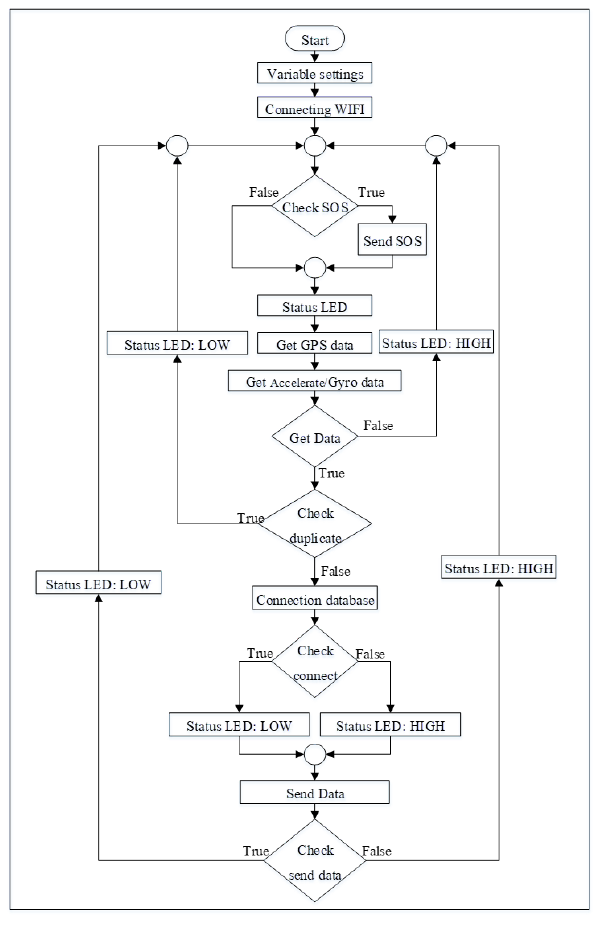
Figure 5. The workflow diagram of the tracking